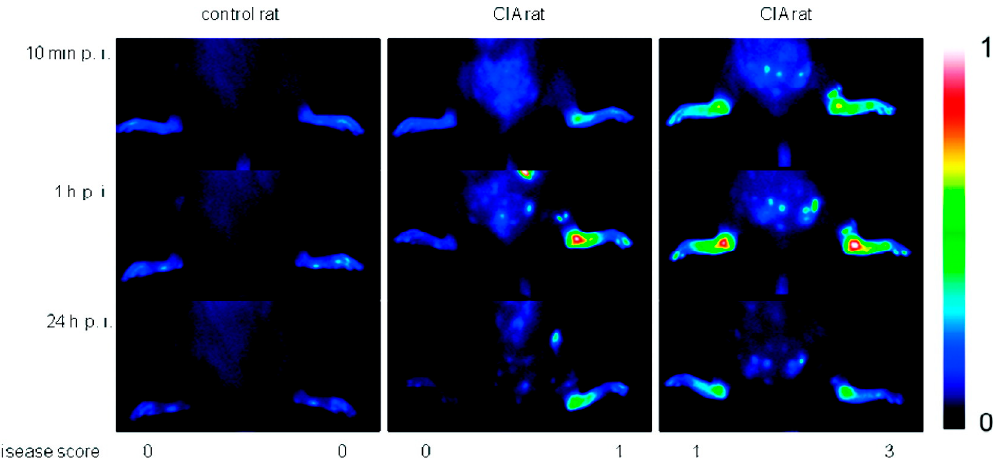
Figure 4. Comparison of fluorescence images in false colors (normalized to a fluorescence reference cube) of a control rat and rats with collagen-induced rheumatoid arthritis (different clinical scores are indicated) after 10 min, 1 h, and 24 h post injection of 6 (4 mg/kg b.w.). One representative example of at least n = 5. Reprinted with permission from [29]. Copyright 2011 American Chemical Society.